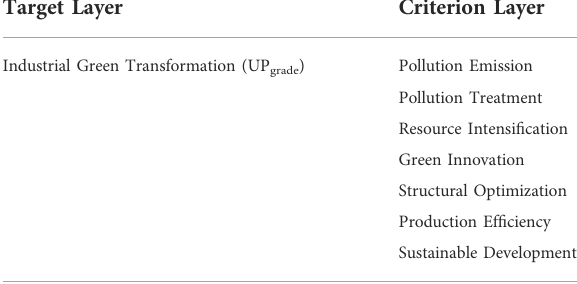
TABLE 1 Industrial green transformation index system.